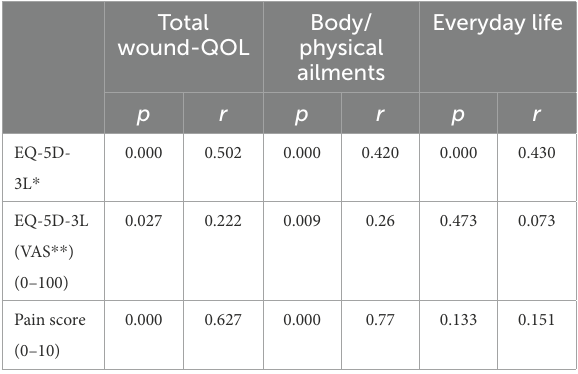
TABLE 3 Convergent validity correlation of the wound-QOL global score with concurrent